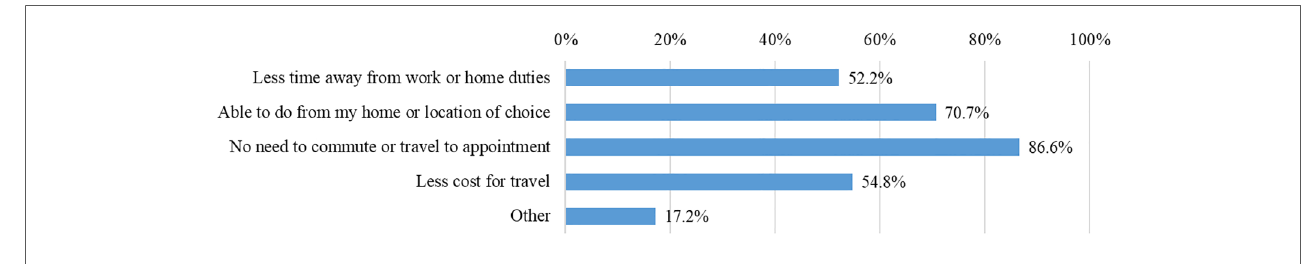
FIGURE 3 Perceived bene fi ts of telehealth.